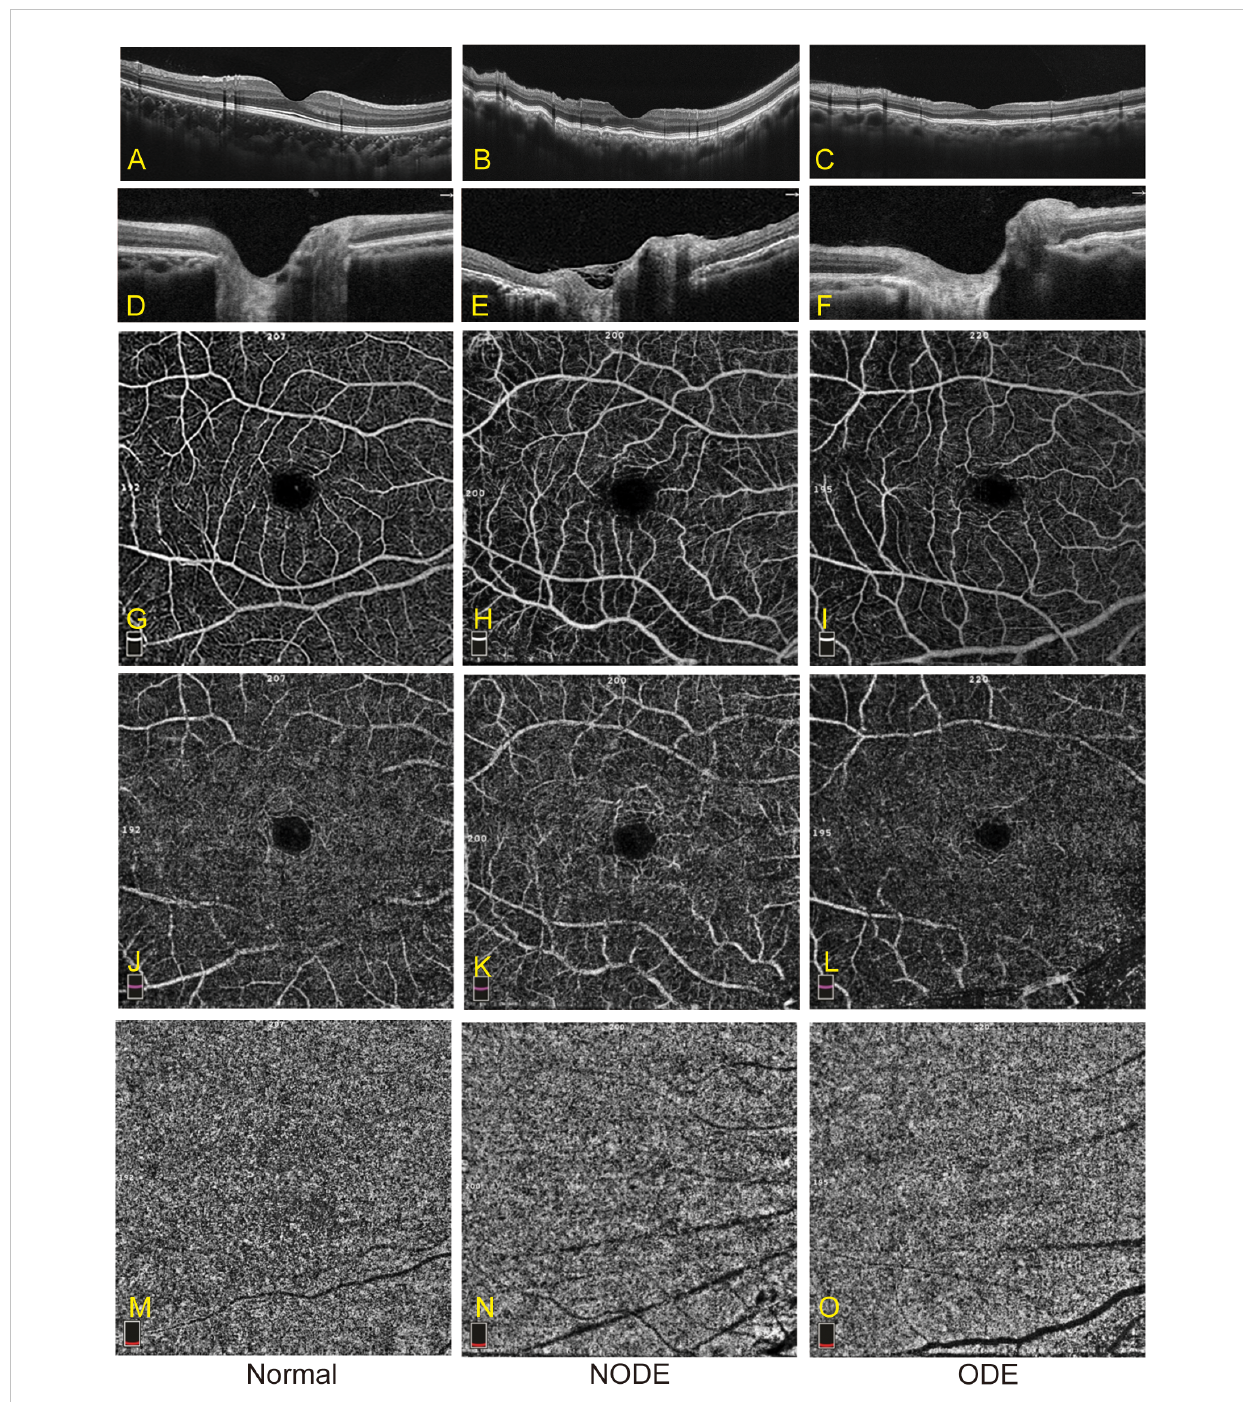
FIGURE 2 Representative images of OCTA in the normal, NODE, and ODE groups. (A – C) show optical coherence tomography (OCT) images of the macula in the normal, NODE, and ODE groups, respectively. The optical coherence tomography (OCT) images of the optic nerve head in the normal, NODE, and ODE groups are displayed in (D – F) , respectively. Macular SLR vessel density map is displayed with the normal (G) , NODE (H) , and ODE (I) groups. (J – L) exhibit macular DLR vessel density map in the normal, NODE, and ODE groups, respectively. (M – O) show macular CC vessel density in the normal, NODE, and ODE groups, respectively. SLR, super fi cial layer; DLR, deep layer; CC,